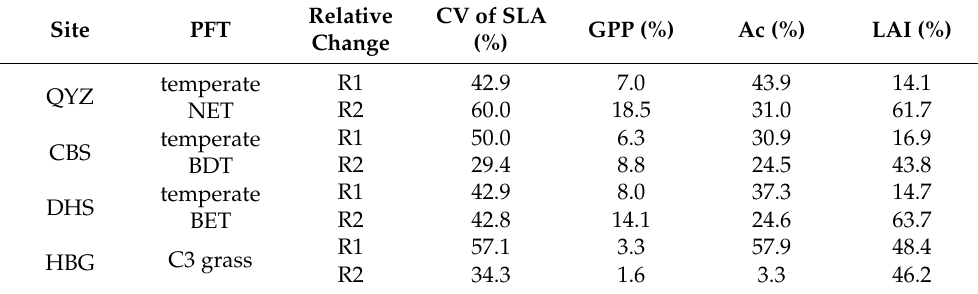
Table 3. The relative changes in GPP, Ac, and LAI modeled with different SLA values. R1 is the relative changes in modeled GPP, Ac, and LAI caused by the observed SLA variation based on model experiments S2, S3, and S4 (Equation (7)). R2 is the relative changes in modeled GPP, Ac, and LAI caused by the SLA variation across models based on model experiments S1, S5, and S6 (Equation (8)). Abbreviations: PFT, plant functional type; NET, needleleaf evergreen tree; BDT, broadleaf deciduous tree; BET, broadleaf evergreen